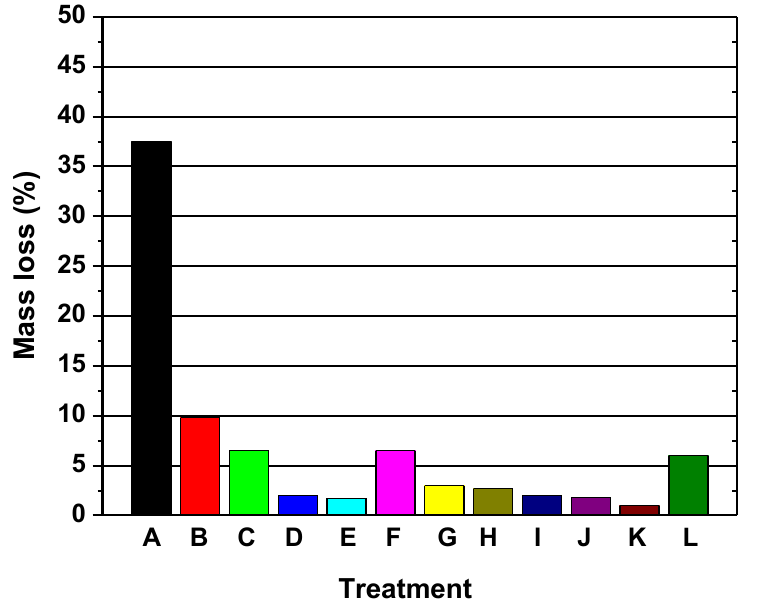
Figure 3. The mass loss (%) caused by the soft-rot decay of wood modified with linear chain anhydrides. A: untreated controls; B: acetic anhydride 7.5%; C: acetic anhydride 15%; D: